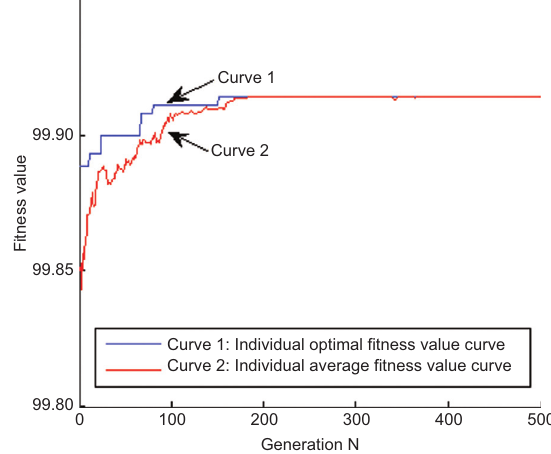
Figure 9. The Convergence Curve when the Crossover Probability is Set to (0.4,